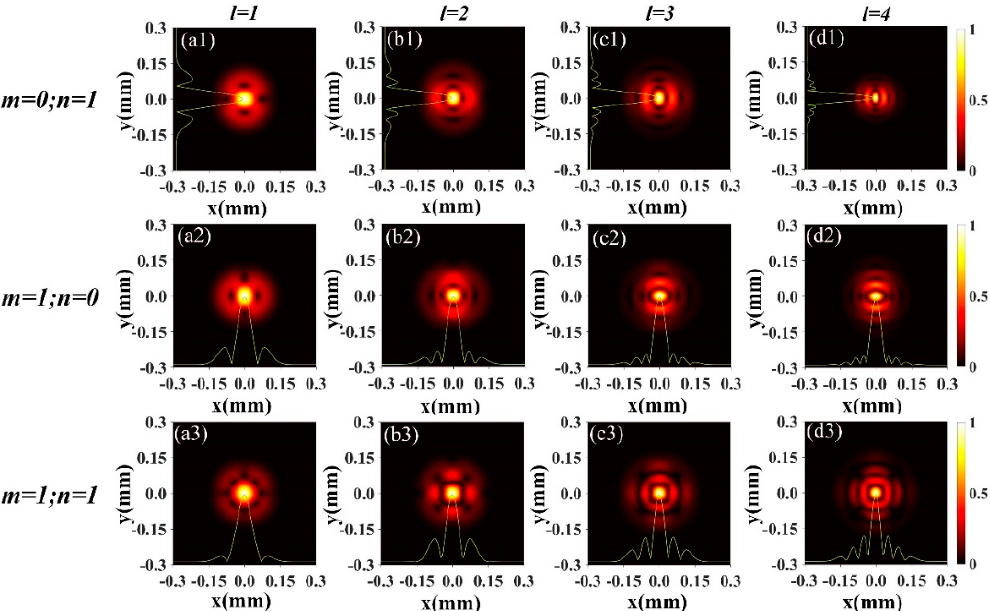
Figure 8. The modulus of the focal plane DOC ( | µ ( ρ ,0; z ) | ) of an HGCSMLG 0l beam for different m , n and the TC. For the first row the solid curve is the cross line x = 0. For the second and third row the solid curve is the cross line y = 0.